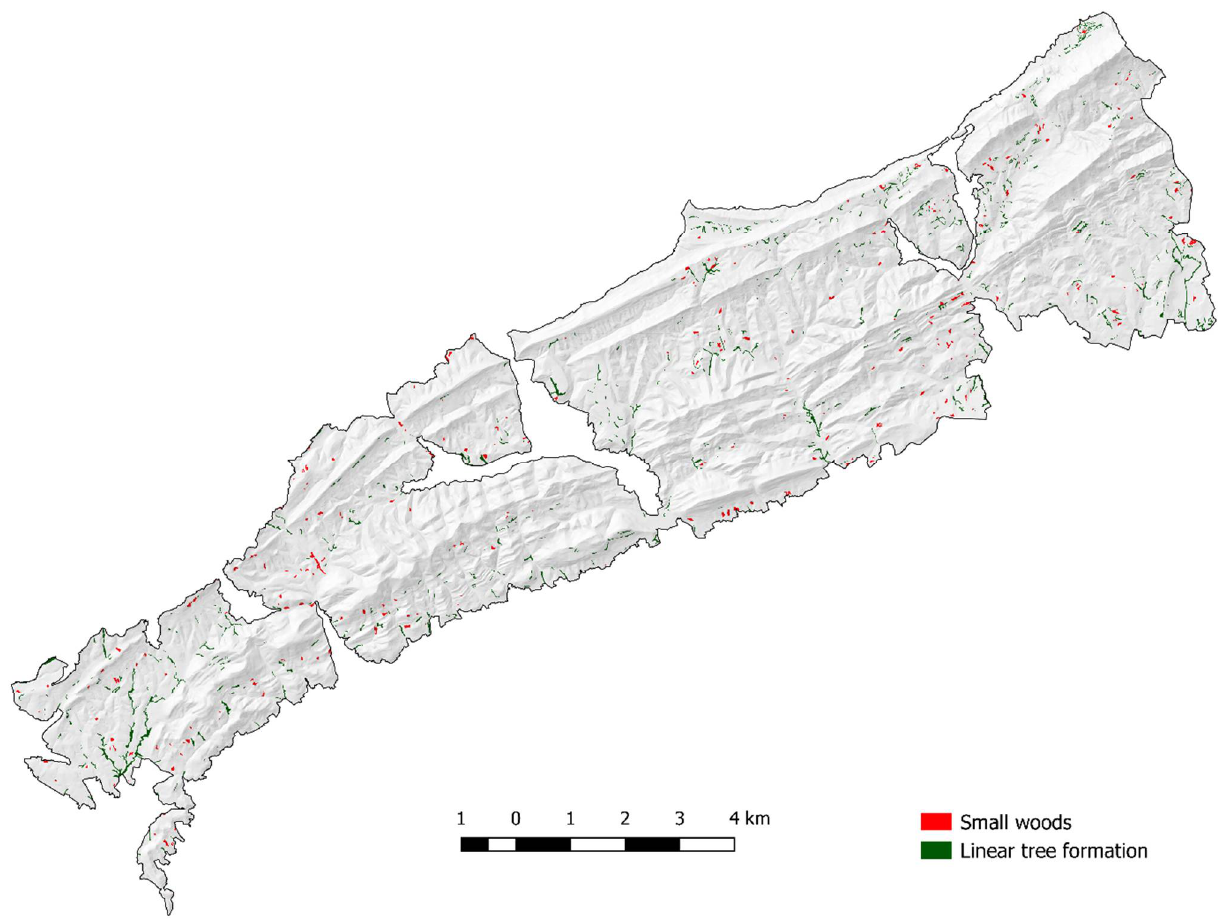
Figure 2. Map of the presence of Small Woods and Linear Tree Formations in 2021. Table 3. Distance analysis of each point of the agricultural and urban surface from a TOF NON A/U or from a forest patch, considering and not considering TOF NON A/U. If all TOF NON A/U would be converted into agricultural areas, the distance would increase significantly, highlighting the important ecological role of TOF NON A/U for the connectivity of big forest patches. With TOF NON A/U Included Without TOF NON Distance Class in the Analysis